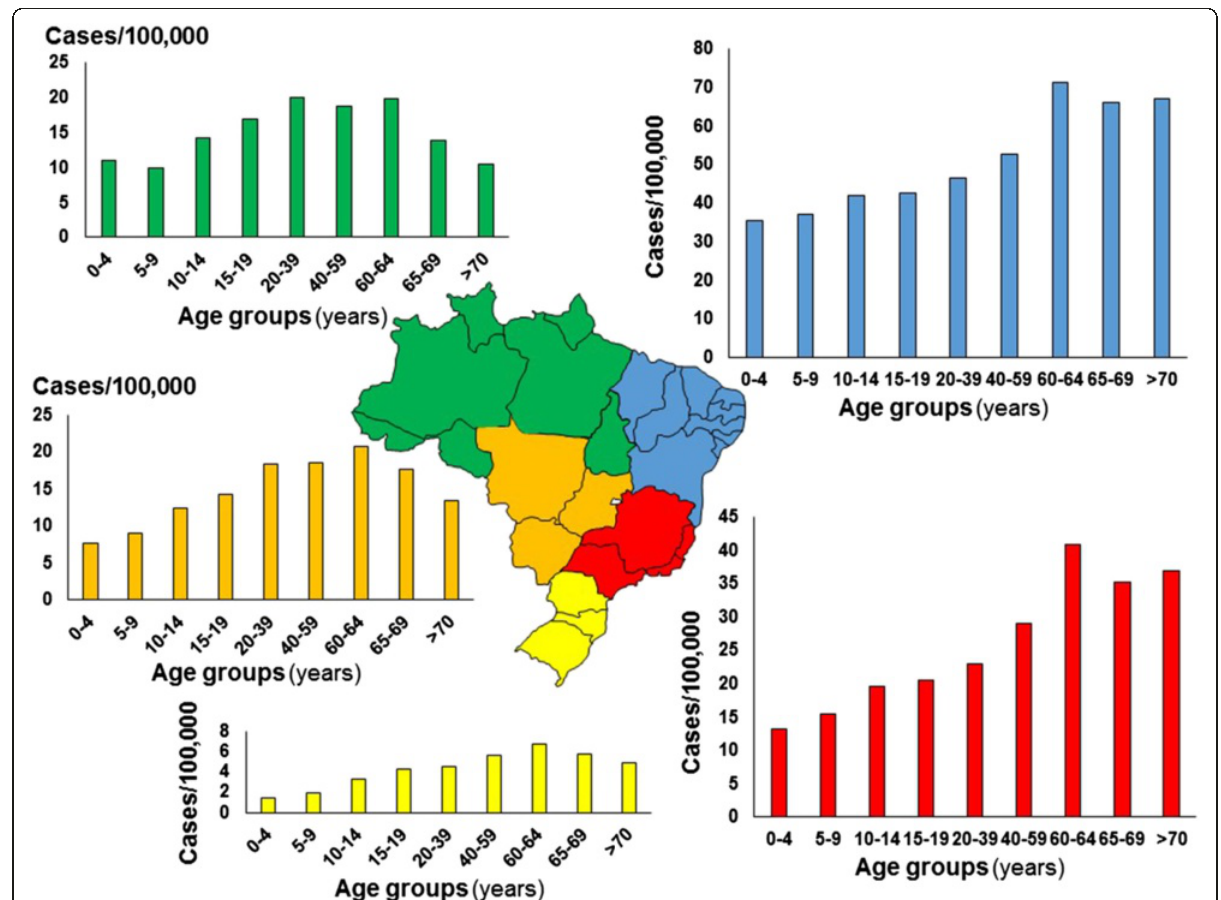
Fig. 6 Age-specific scorpion sting incidence (per 100,000 people) in Brazil according to age and